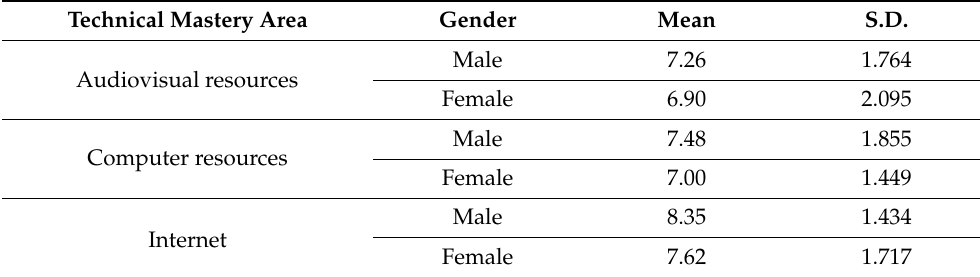
Table 2. Means and standard deviations.